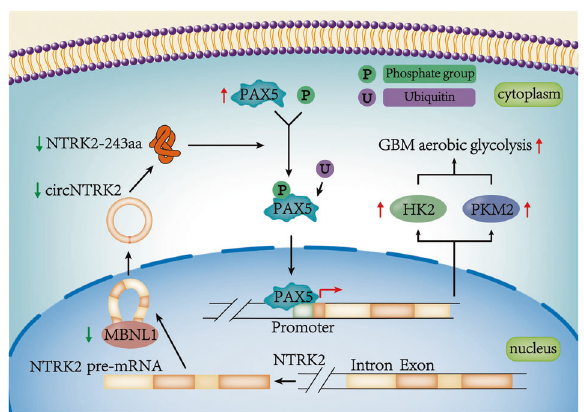
Fig. 8 Schematic diagram of MBNL1/circNTRK2/PAX5 pathway to regulate glycolysis and proliferation in GBM